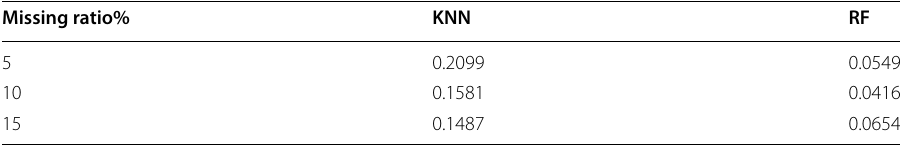
Table 5 RMSE of KNN and RF imputation at different ratios on the ID fan dataset Missing